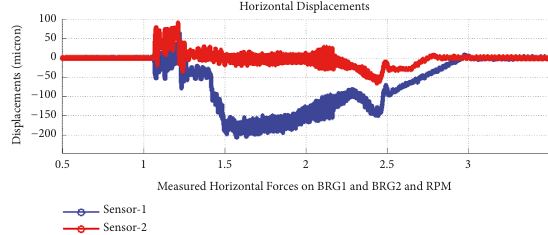
Figure 16: Experimental rotor horizontal displacements during a landing test at DE (blue line) and NDE (red line) rotor nodes.